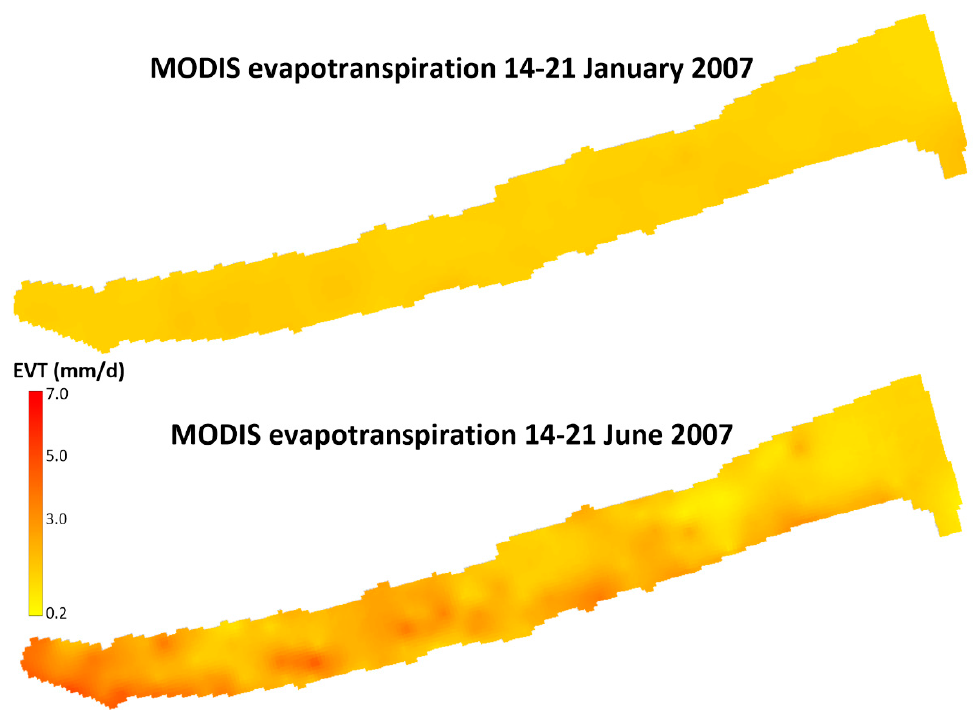
Figure 3. Maximum evapotranspiration rate maps for the 14–21 January 2007 period ( upper panel ) and for the 14–21 June 2007 period ( lower panel ) re-interpolated over the model grid using the kriging algorithm.